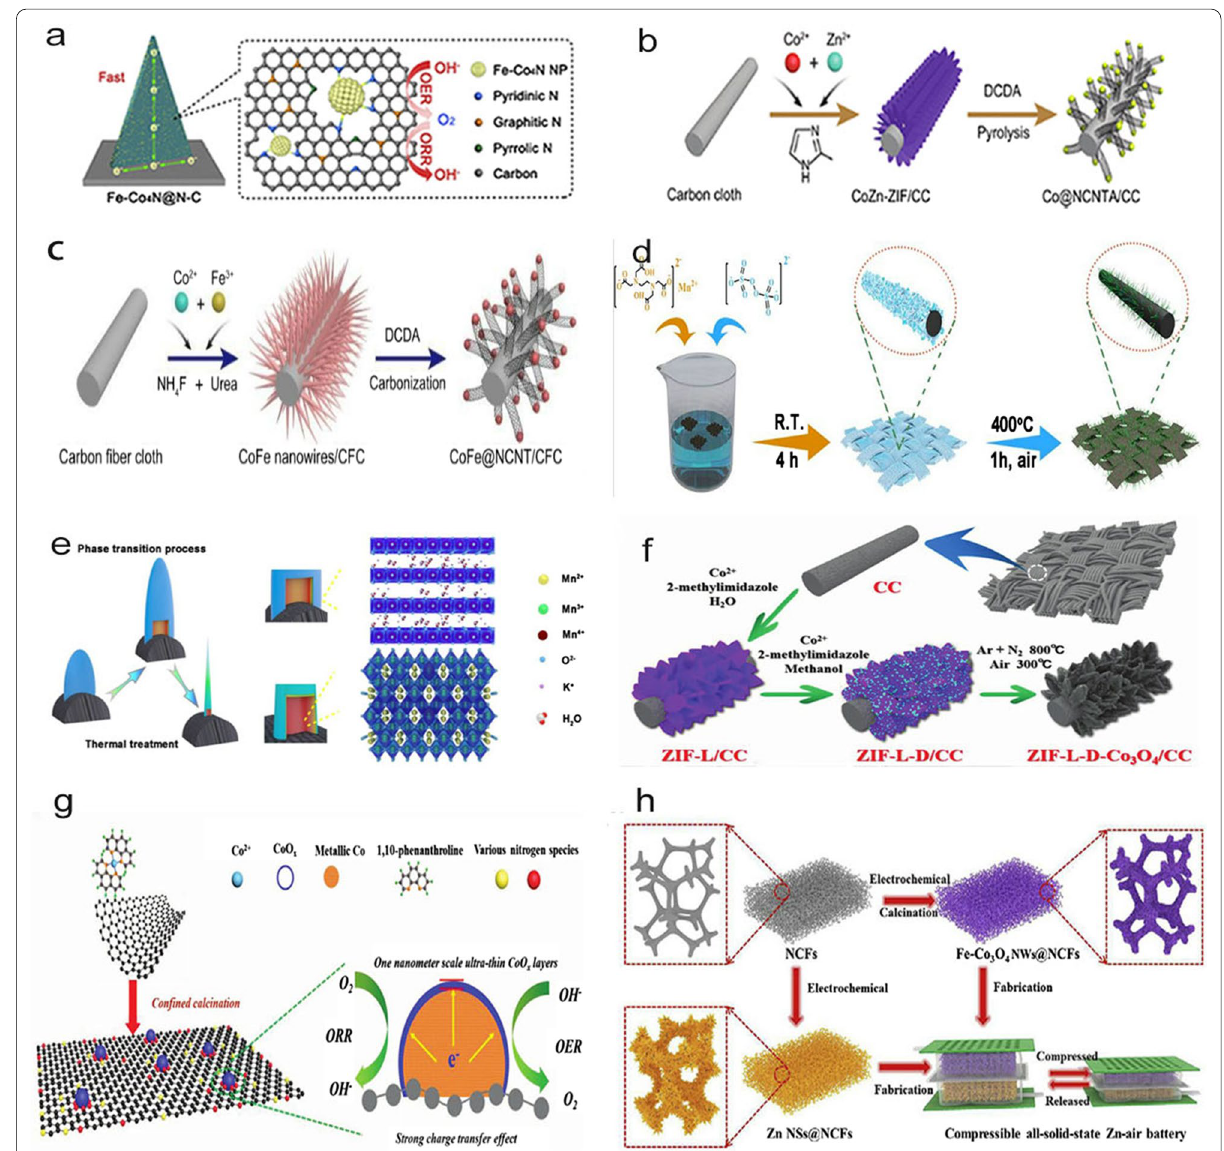
Fig. 1 a Schematic of the Fe-Co 4 N@N–C nanosheet grown on CC for application in the bifunctional oxygen reaction [56]. b Schematic depicting the synthetic process for Co@NCNTAs [85]. c Schematic of the synthetic process for CoFe@NCNT/CFC [98]. d Schematic of the preparation of MnO x -CC-400 [2]. e Proposed phase transition of manganese oxide on CC via a thermal treatment [2]. f Schematic of the ZIF-L-D-Co 3 O 4 /CC formation process [24]. g Schematic of a 1 nm-CoO x layer on the metallic substrate of Co/N-RGO [23]. h Schematic of the fabrication processes for the squeezable and rechargeable all-solid-state ZABs